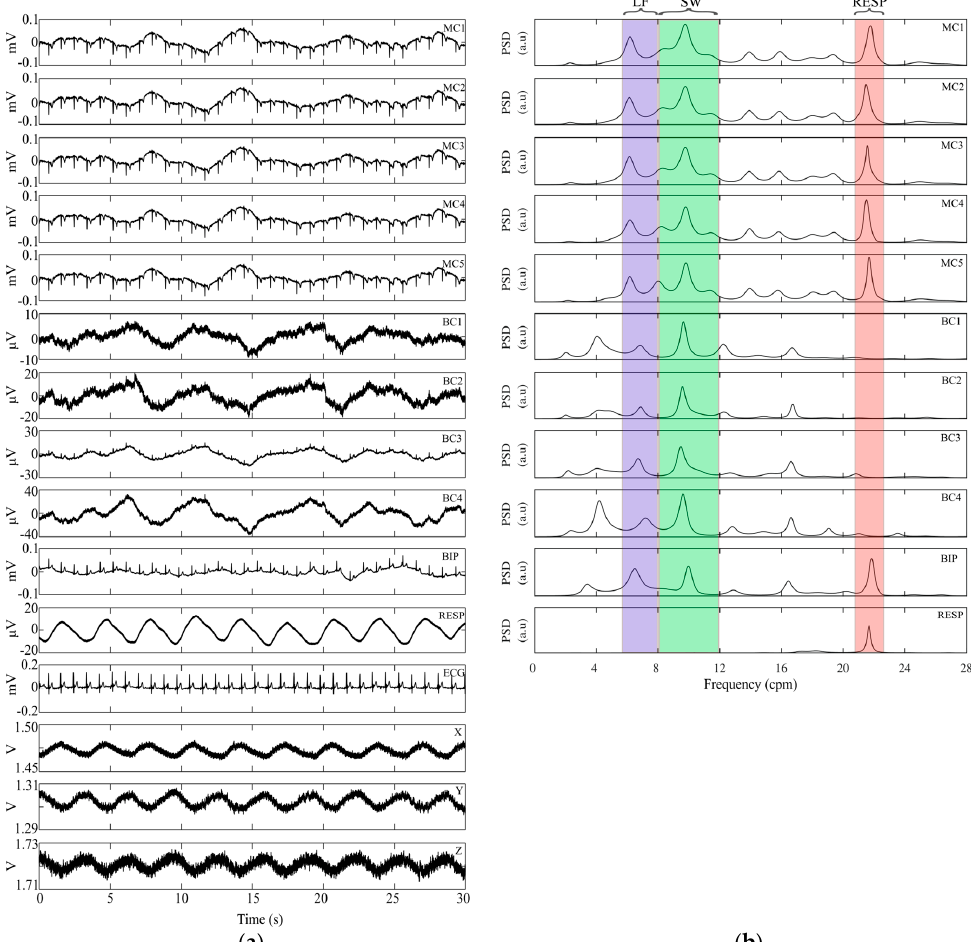
Figure 5. ( a ) Thirty seconds of signals: monopolar concentric (MC1-5), bipolar concentric (BC1-4) with adhesive material below navel position; bipolar (BIP), respiration (RESP), ECG ML-Lead I and accelerometer signals (X, Y, Z); ( b ) Power spectral density of signals shown on the left. Table 3. Mean and standard deviation of the parameters defined for SW identification and interference quantification of surface abdominal signals picked up with different recording factors. Signals recorded in BN position in 10 volunteers.